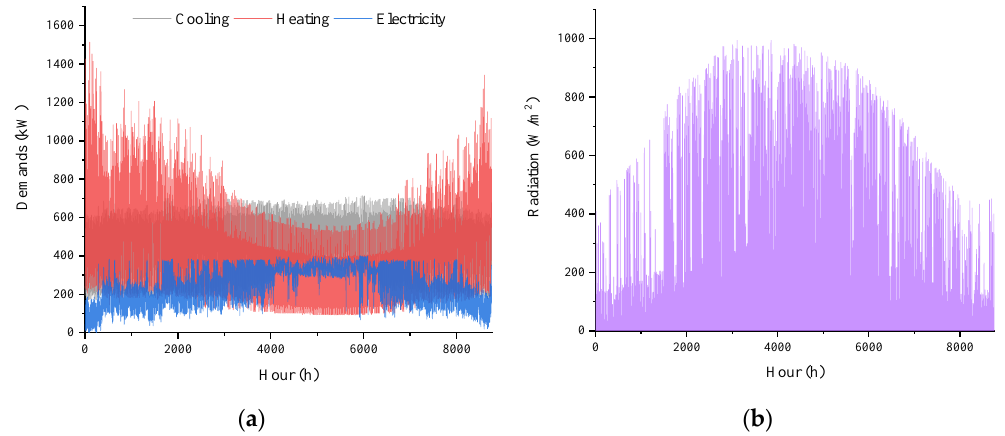
Figure 5. ( a ) Annual demands of the hotel; ( b ) Annual solar radiation. Table 2. Simulated cases.